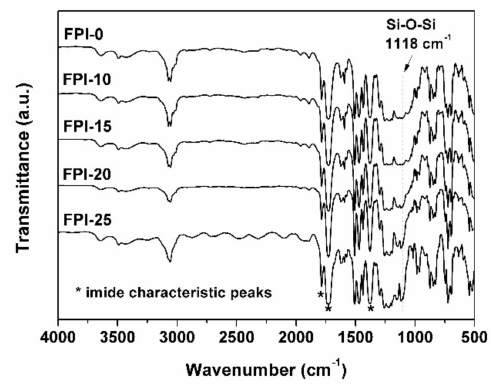
Figure 4. FT-IR spectra of PI films.